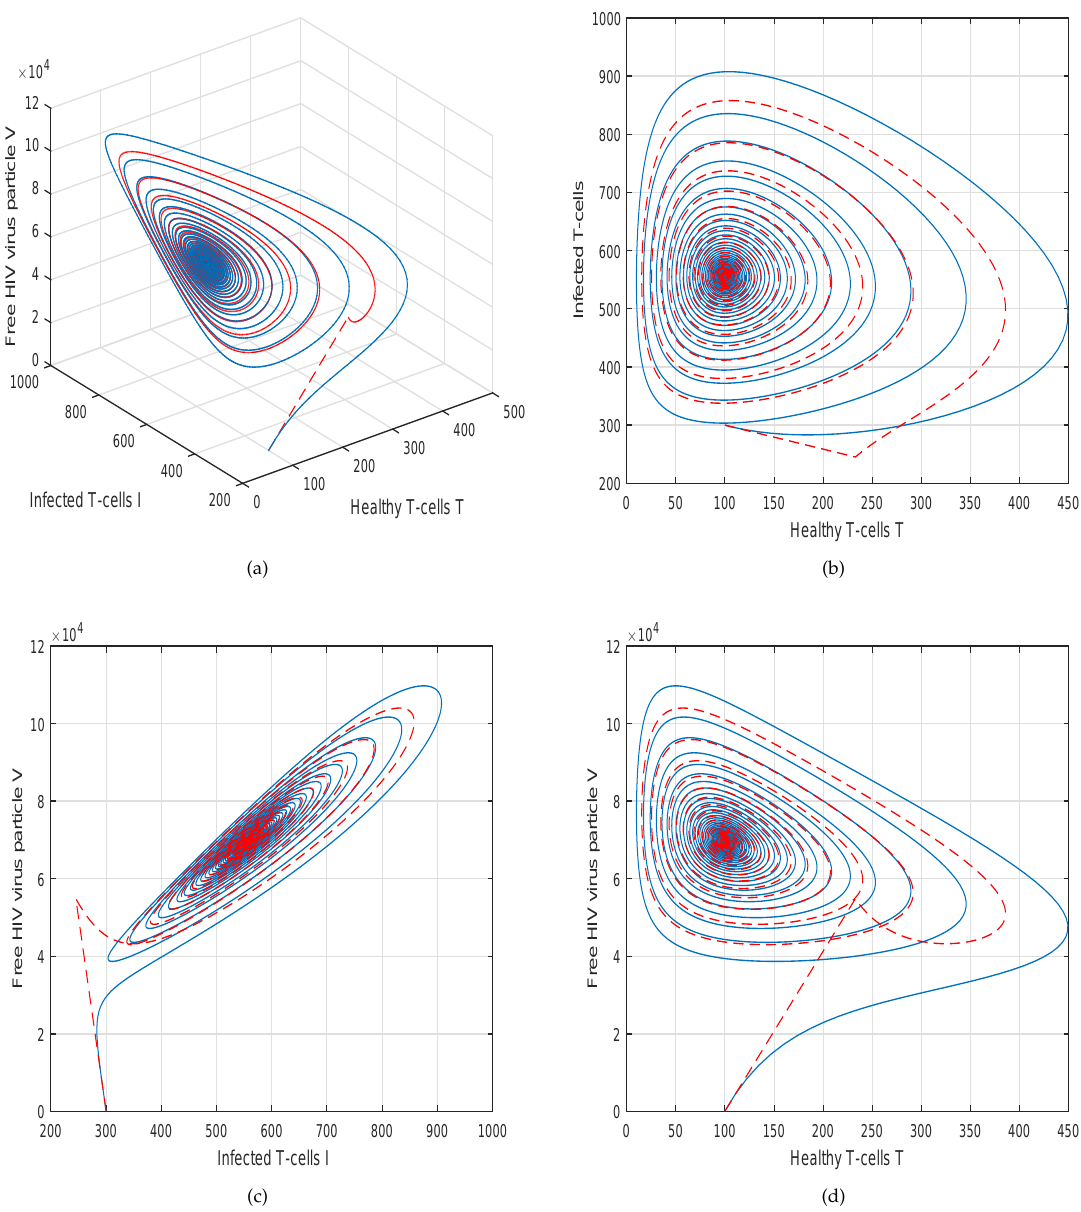
Figure 8. Illustration of the ( a ) chaotic behavior, ( b ) phase portrait of healthy CD4 + T-cells verses infected CD4 + T-cells, ( c ) phase portrait of infected CD4 + T-cells verses free HIV virus particles and ( d ) phase portrait of healthy CD4 + T-cells verses free HIV virus particles of the fractional model (2) of HIV infection with fractional-order ϑ =